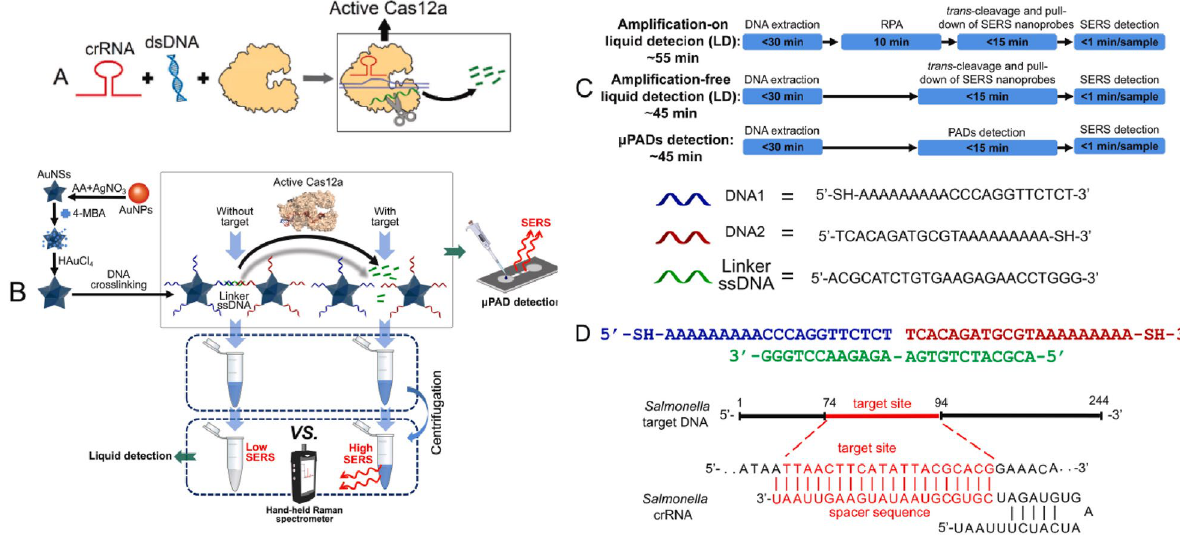
Fig. 7 The principle of Raman spectrometer-read CRISPR/Cas biosensor for nucleic acids detection of pathogenic bacteria. A The activation of CRISPR/Cas12a for trans-cleavage. The green ribbon represents single-stranded DNA subject to trans-cleavage. B The preparation of gold nanostar@4-mercaptobenzoic acid@goldnanoshell structures (AuNS@4-MBA@Au) and their utility in combination with CRISPR/Cas12a for SERS-based bacterial detection for both in-tube and μPAD detection. DNA1 and DNA2 were colored as blue and red, respectively and linker ssDNA was green. C The schematics of the biosensing processes with the estimated assay time for each step. D The nucleic acid sequences required for the proposed biosensor and the hybridization of linker ssDNA with DNA1 and DNA2. AA ascorbic acid. (Figure from Zhuang et al., Biosensors